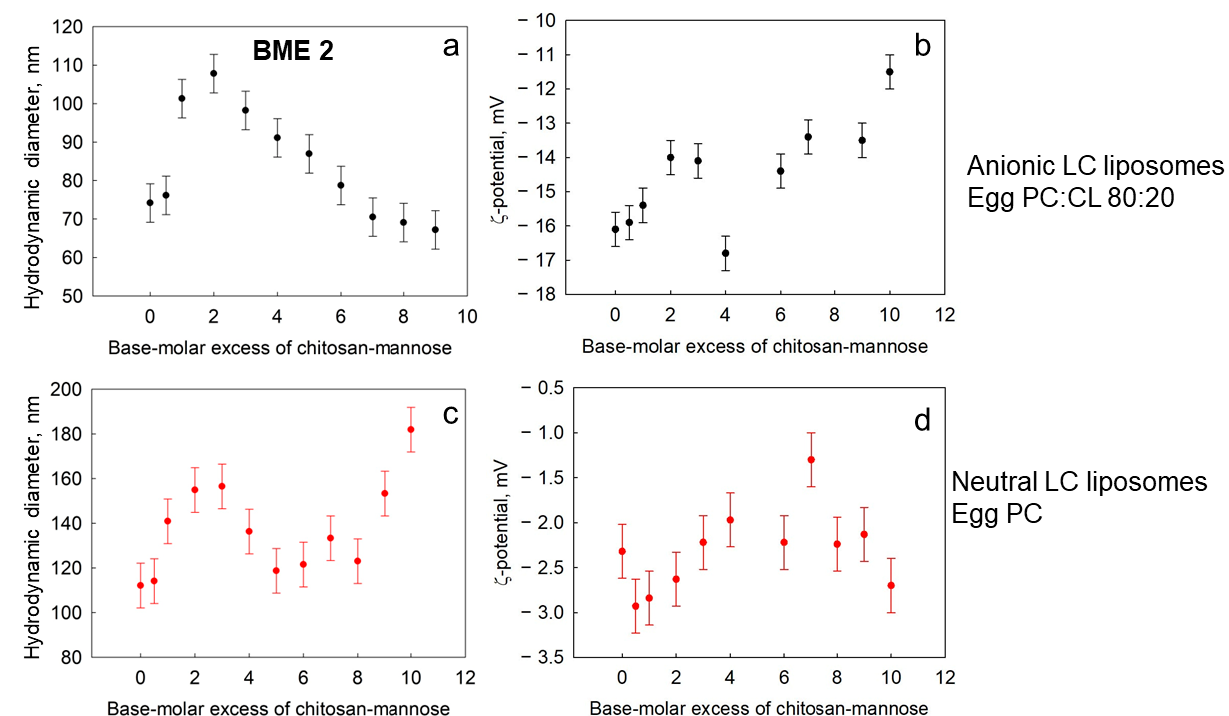
Figure 2. Dependance of main physicochemical properties of liposomal complex with ChitMan: egg PC: CL 80:20 liposomes (Dh, nm ( a ) and ζ -potential, mV ( b )) and egg PC liposomes (Dh, nm ( c ) and ζ -potential, mV ( d )). SD, n = 3. 0.02 M Na-phosphate buffer solution, pH 7.4, 22 ◦ C.